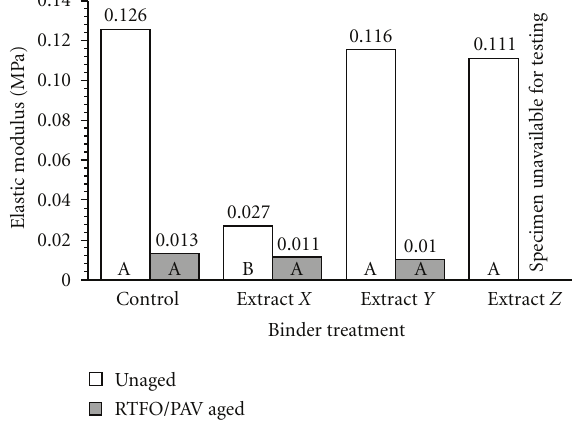
Figure 14: Maximum tensile stress at failure of original and PAV aged control binder and binder with finish extracts tested at − 12 ◦ C. Statistical comparisons were made within each stage of aging.